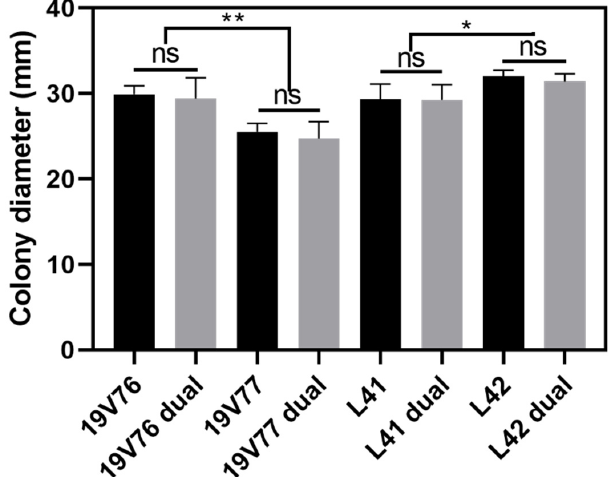
Figure 2. Colony diameter (mm) of the tested V. dahliae isolates recorded after seven days growing in darkness at 25 ◦ C. Growth competition of 19V76 vice versa 19V77, and L41 vice versa L42 were darkness at 25 °C. Growth competition of 19V76 vice versa 19V77, and L41 vice versa L42 were assessed in dual culture assays (labelled “dual”). Data from the two assays were pooled due to the insignificant difference found between the two repeated assays. Bars represent standard errors of means ( n = 12). Asterisks indicate significant differences among treatments ( p = 0.05 for * and p = 0.01 for **).